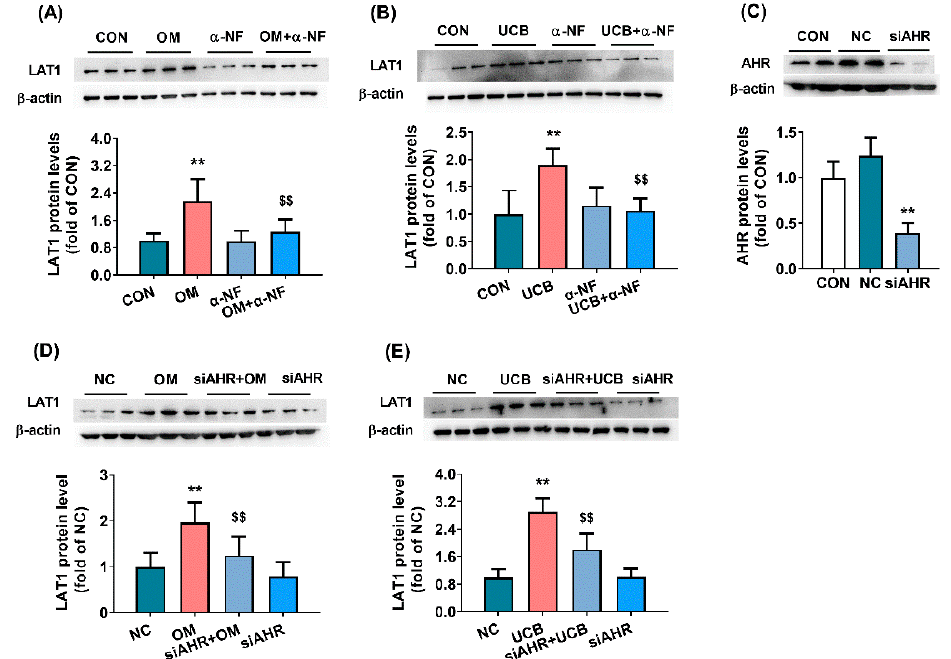
Figure 3. Roles of AhR in UCB-mediated regulation of LAT1 protein in HCMEC/D3 cells. Effects of AhR antagonist α -naphthoflavone ( α -NF) on upregulation of LAT1 protein by omeprazole (OM, ( A )) or UCB ( B ). The expression of the AhR protein in HCMEC/D3 cells treated with siRNA of AhR (siAHR, ( C )). Effects of AhR gene silencing on upregulation of LAT1 protein by OM ( D ) and UCB ( E ). Data are presented as the mean ± SD ( n = 6). ** p < 0.01 versus control (CON) cells or cells scrambled siRNA (NC). $$ p < 0.01 versus cells treated with OM or UCB.